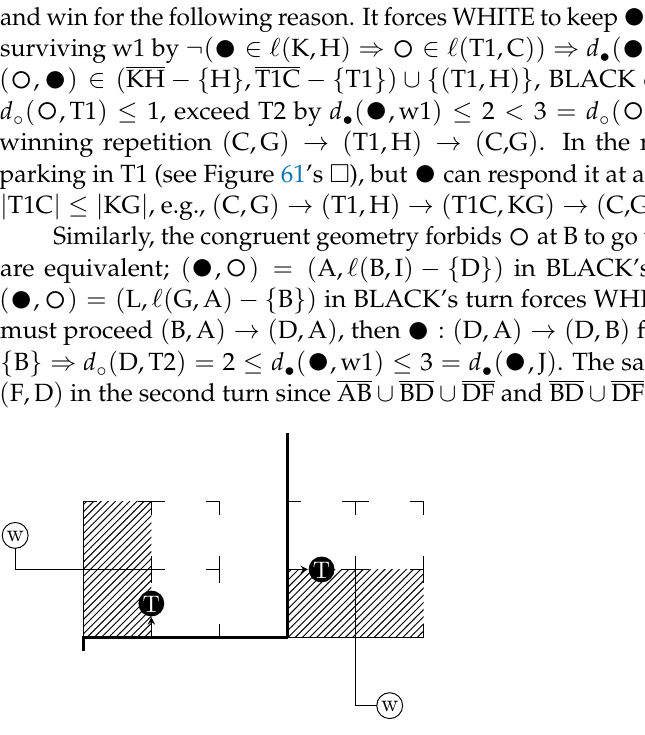
Figure 99. One-way road.